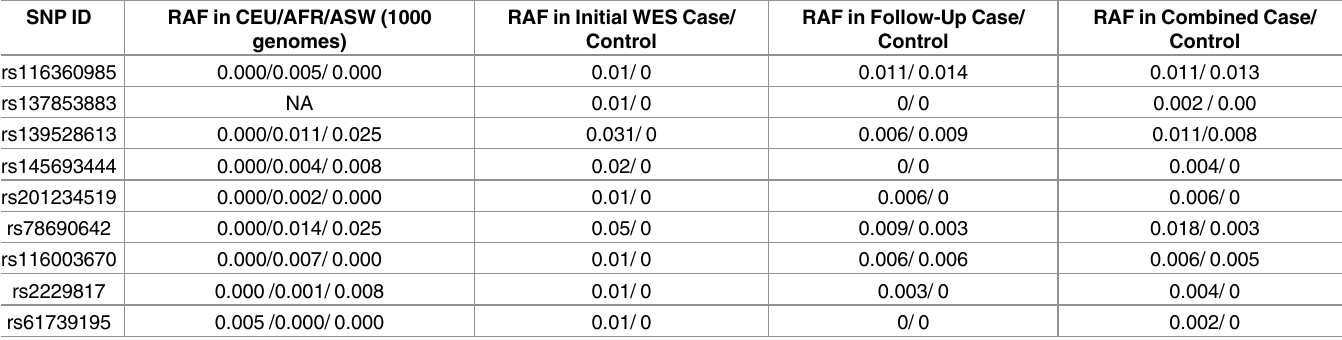
Table 4. Allele frequencies of the variants